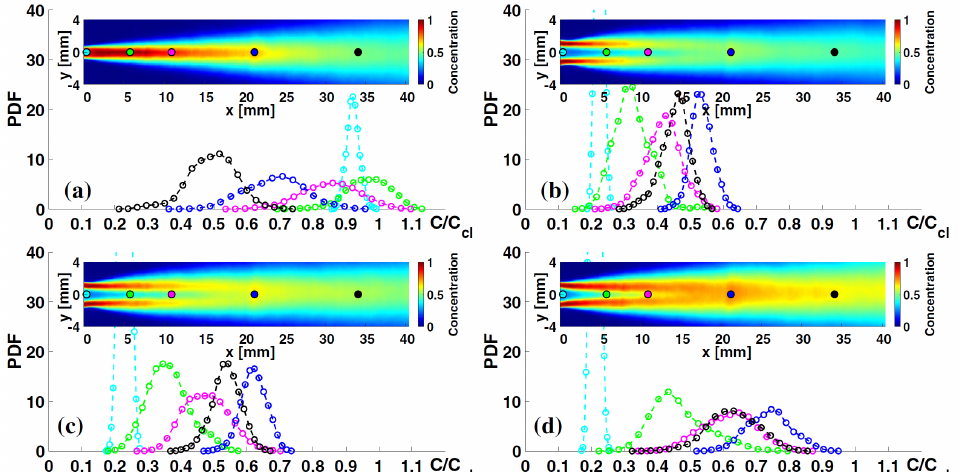
Figure 8. Probability density functions along the centerline (for geometry, see Figure 3g). M sec = 1 for all cases. ( a ) M jet = 0, ( b ) M jet = 0.5, ( c ) M jet = 1, ( d ) M jet = 3.8. Figure adapted from